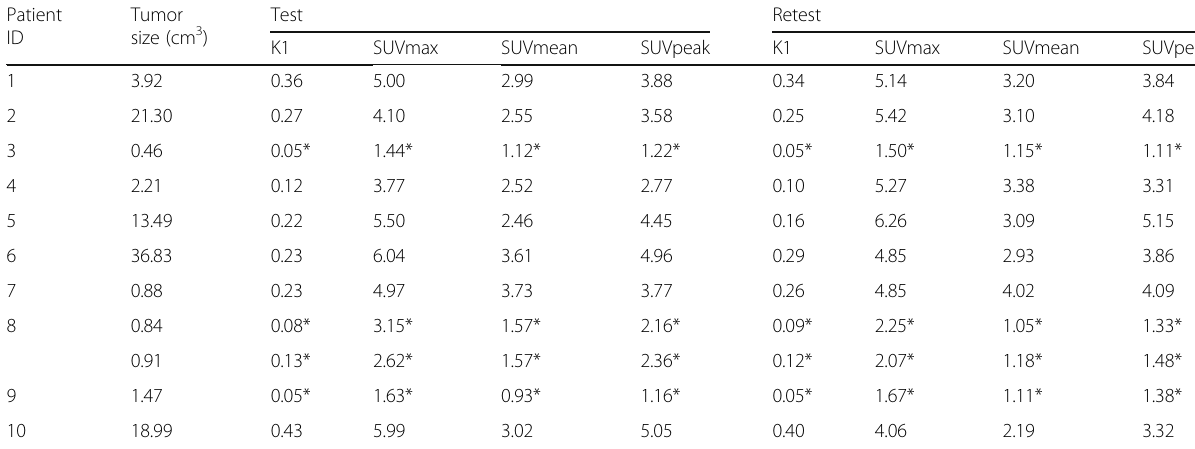
Table 1 Tumor blood flow values for both test and retest scans of all patients for volumes of interest (VOIs) drawn from (PET)/computed tomography